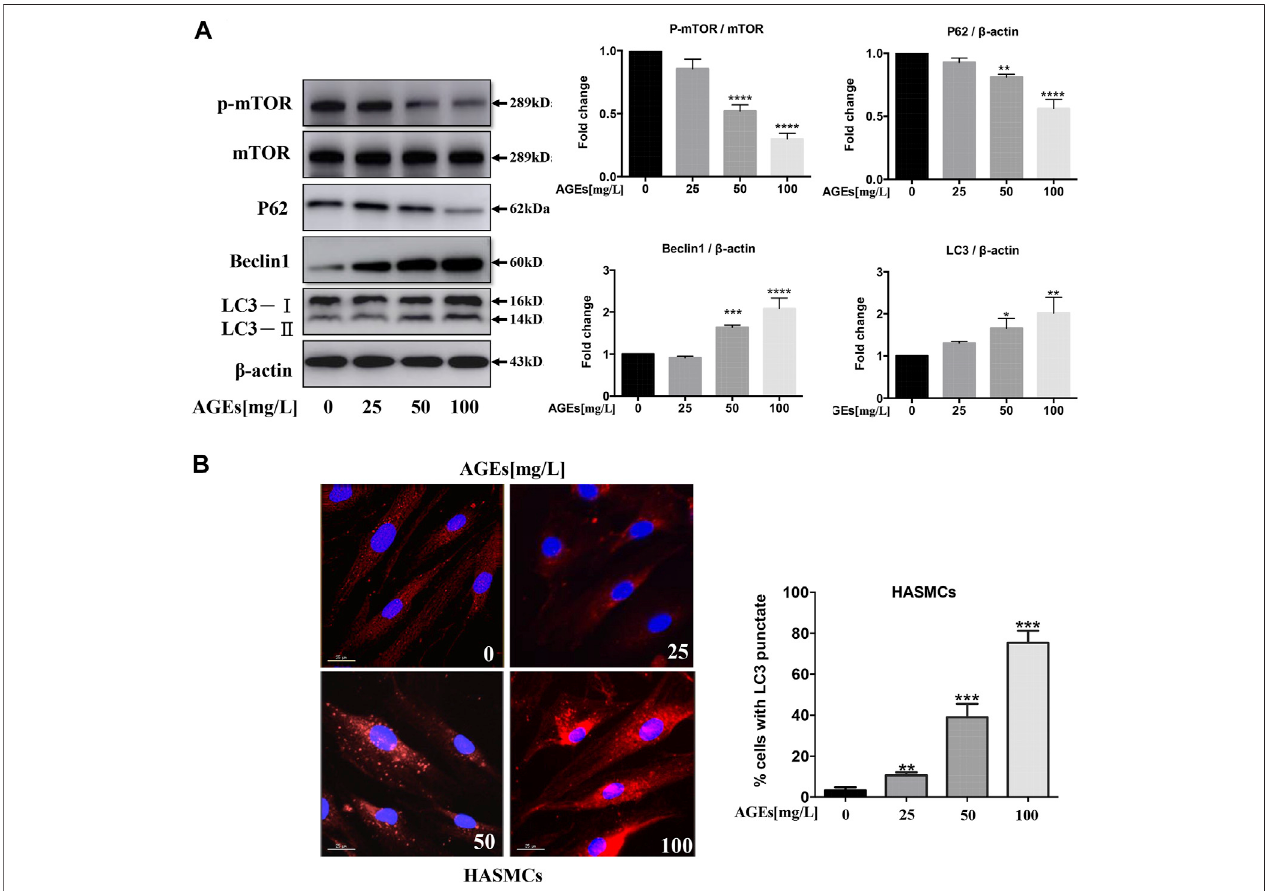
FIGURE 2 | AGEs induce autophagy via mTOR signaling in HASMCs. Dose-dependent study of AGEs-induced autophagy in HASMCs at AGEs concentrations from 0 to 100 mg/L with 24 h ’ treatment. (A) Western blot analysis of mTOR and autophagy-related proteins (p62, beclin1, and LC3) in AGEs-treated HASMCs. (B) Immuno fl uorescence analysis of LC3-II puncta formation (red color represents LC3-II, blue represents DAPI; scale bar (cid:2) 25 μ m). Data are presented as the fold change compared with the control group. Each point represents the mean ± SD ( n (cid:2) 3/group); *p < 0.05, ** p < 0.01, *** p < 0.001.